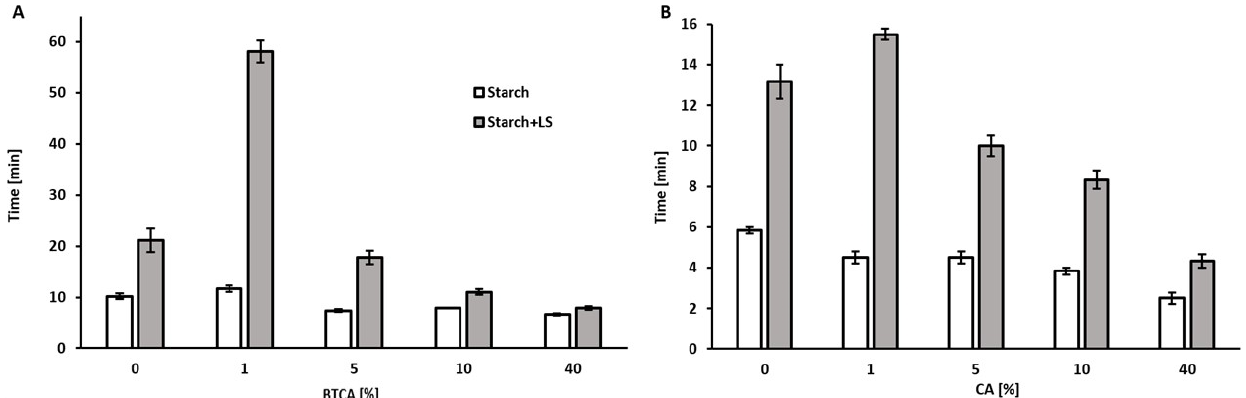
Figure 3. Wet resistance of the starch-based adhesive, with and without enzymatically polymerized LS, and containing different amounts of BTCA ( A ) and CA ( B ). Error bars indicate the standard deviation (n = 3).